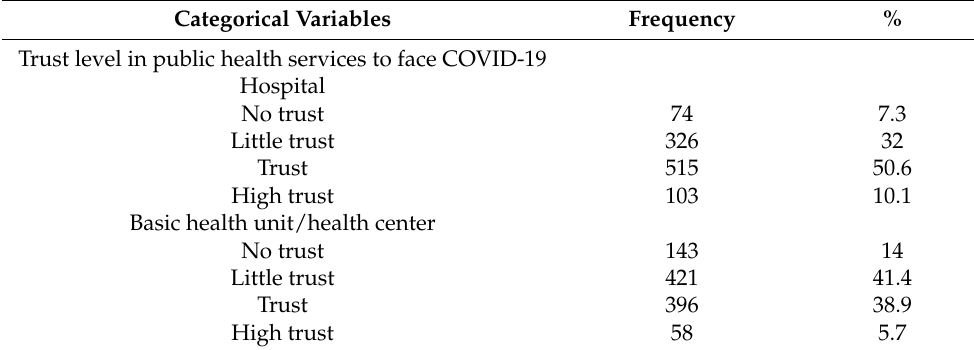
Table 3. Characteristics of the final study sample: social thermometer ( n =